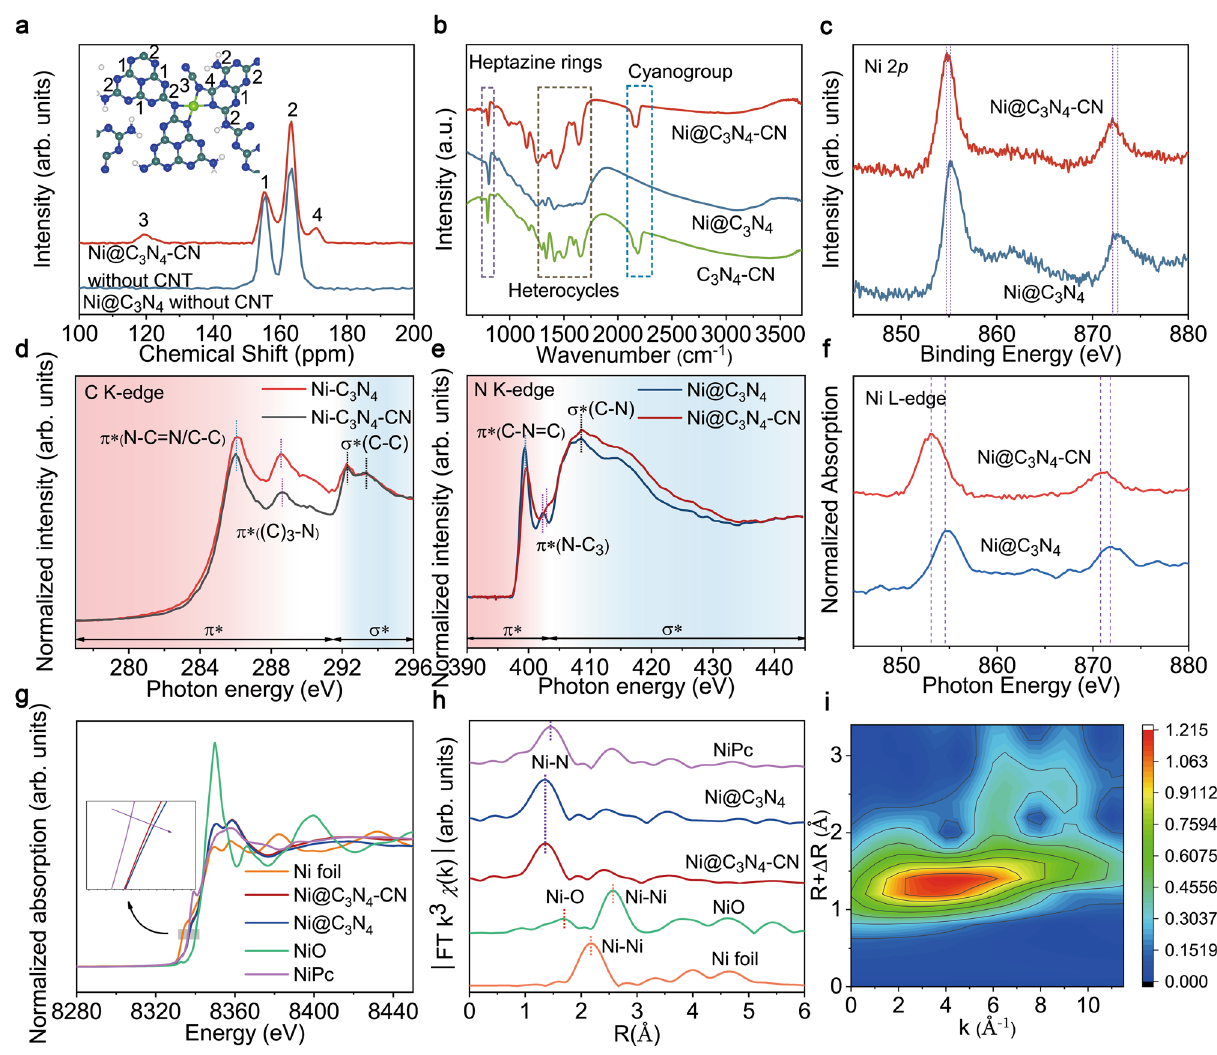
Fig. 3 | Electronic structure characterization of catalysts. a Solid-state 13 C MAS NMR spectraof Ni@C 3 N 4 -CN, Ni@C 3 N 4 without CNT. b FT-IR spectra of Ni@C 3 N 4 - CN, Ni@C 3 N 4 and C 3 N 4 -CN catalyst. c High-resolution XPS of Ni 2 p spectra. d XANES spectra of C K-edge. e XANES spectra of N K-edge. f XAS spectra of